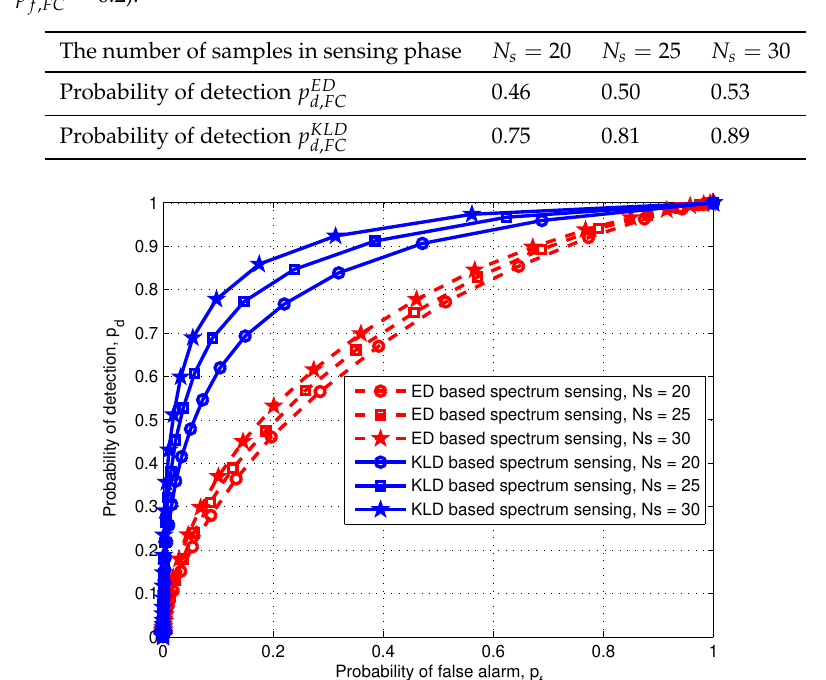
Figure 3. Receiver operating characteristic (ROC) curves at FC of the proposed and conventional